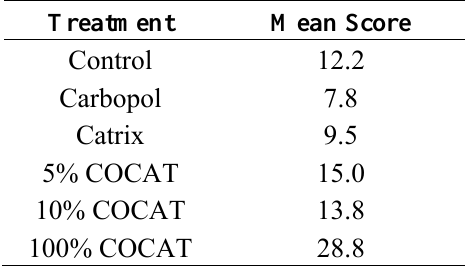
Table 1. Comparative and dose-response study, detail of histological